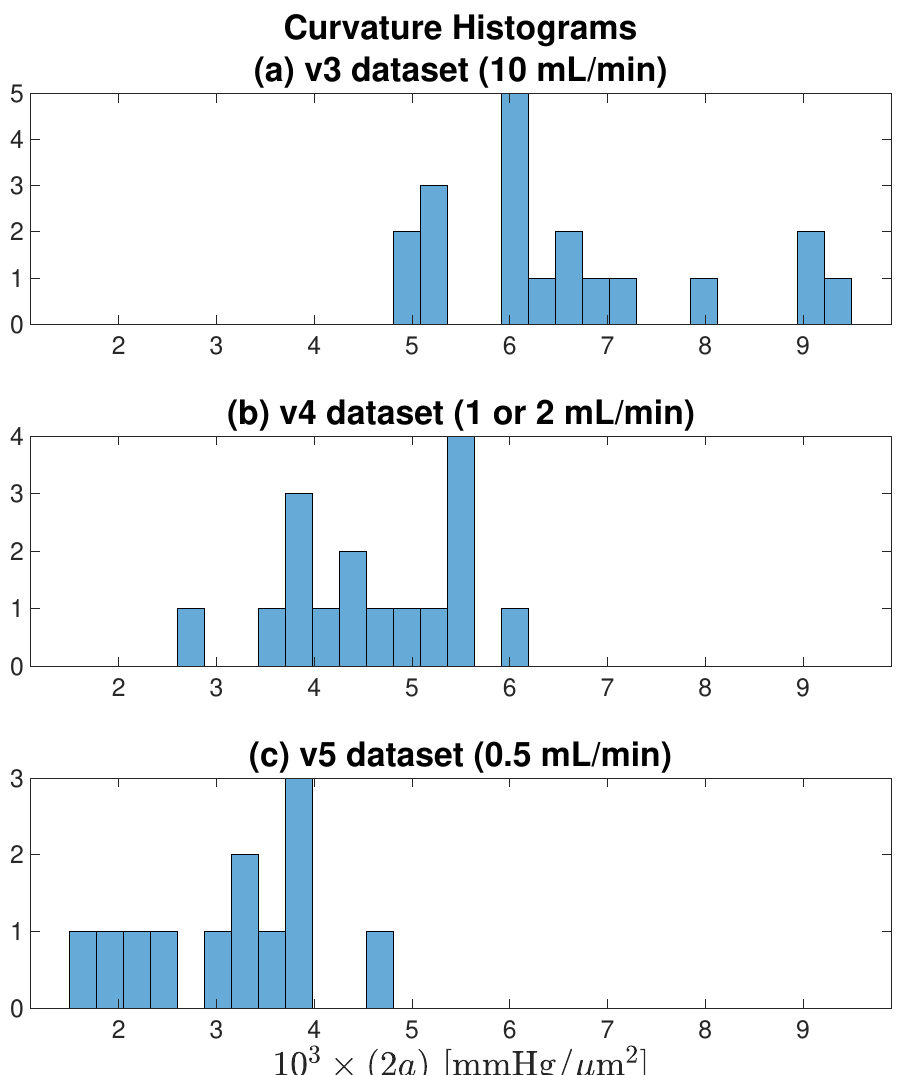
Figure 10. Curvature histograms for each of the [v3, v4, v5] datasets illustrated in Figure 7. As flow rate decreases from ( a ) 10 → ( b ) [1 or 2] → ( c ) 0.5 mL/min, average curvature decreases, meaning that the parabolic/paracosh curves become ‘flatter’ with shallower wings. For fixed K t , a flatter curvature implies reduced